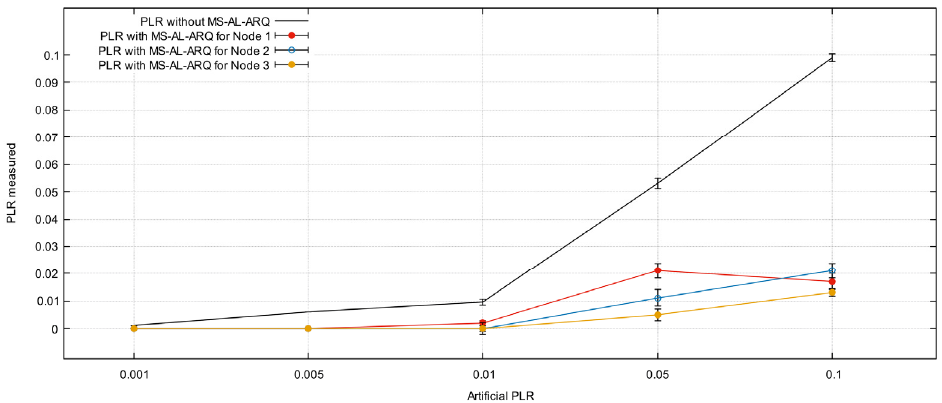
Figure 12. MS-AL-ARQ packet loss rate (PLR) for burst length = 12.